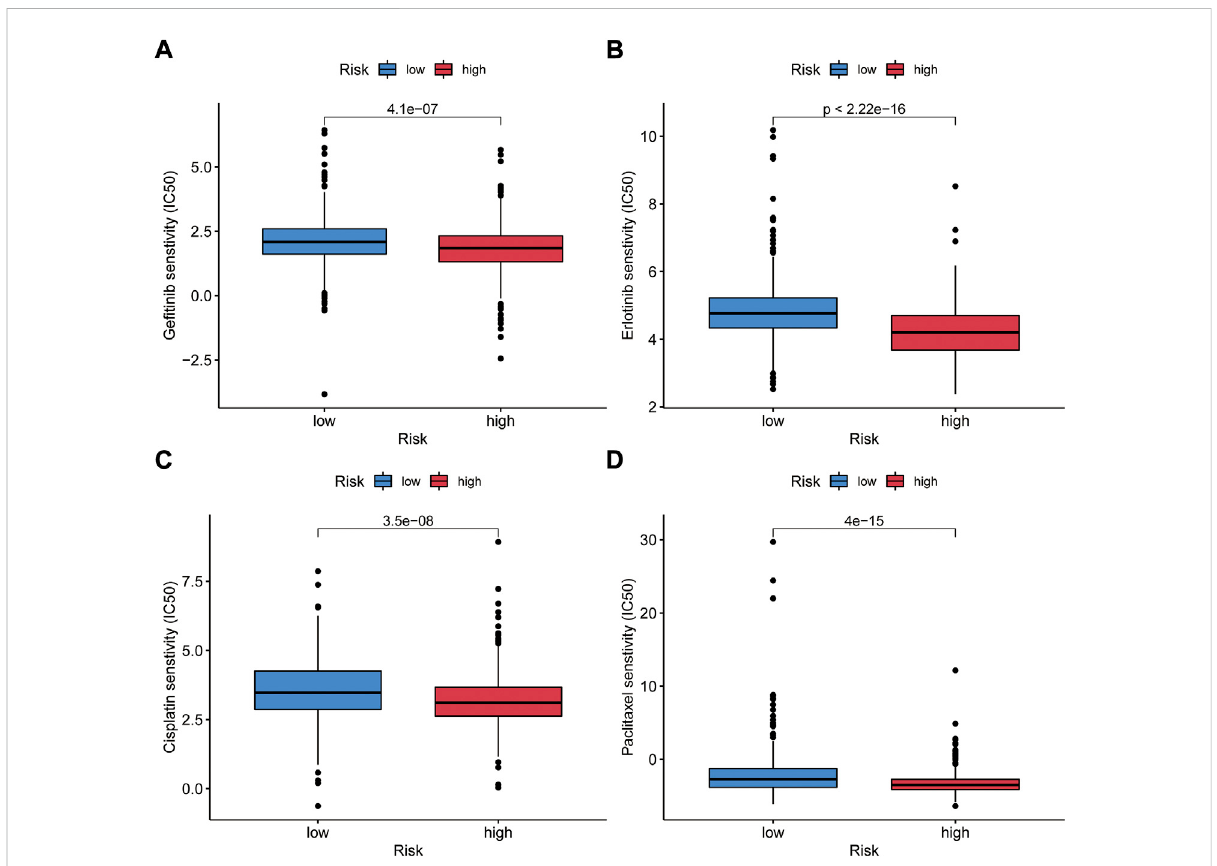
FIGURE 11 Validation of the relationship between GIrLncSig and the sensitivity of general chemotherapy and targeted therapy. IC50 was calculated for ge fi tinib (A) , erlotinib (B) , cisplatin (C) and paclitaxel (D) in two groups. IC50, the half-maximal inhibitory